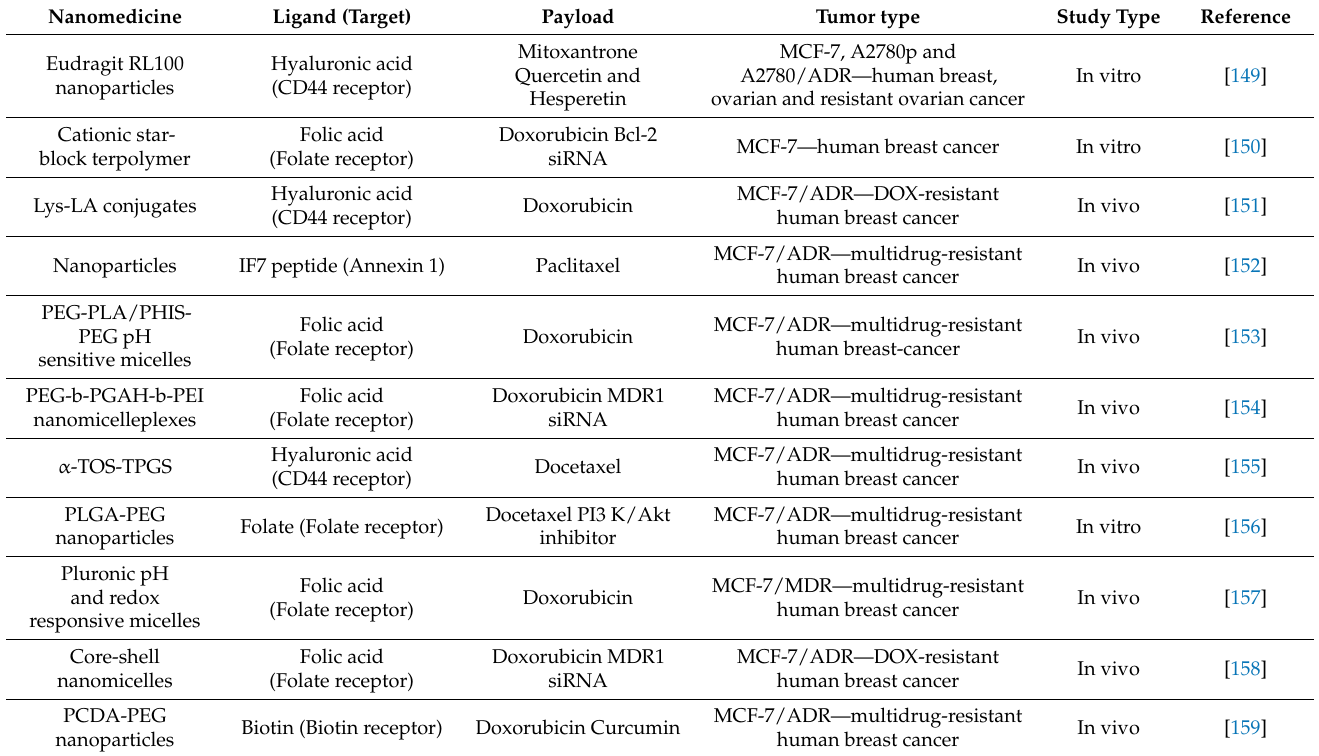
Recent progress in overcoming cancer drug resistance in breast cancer by using actively-targeted nanomedicines